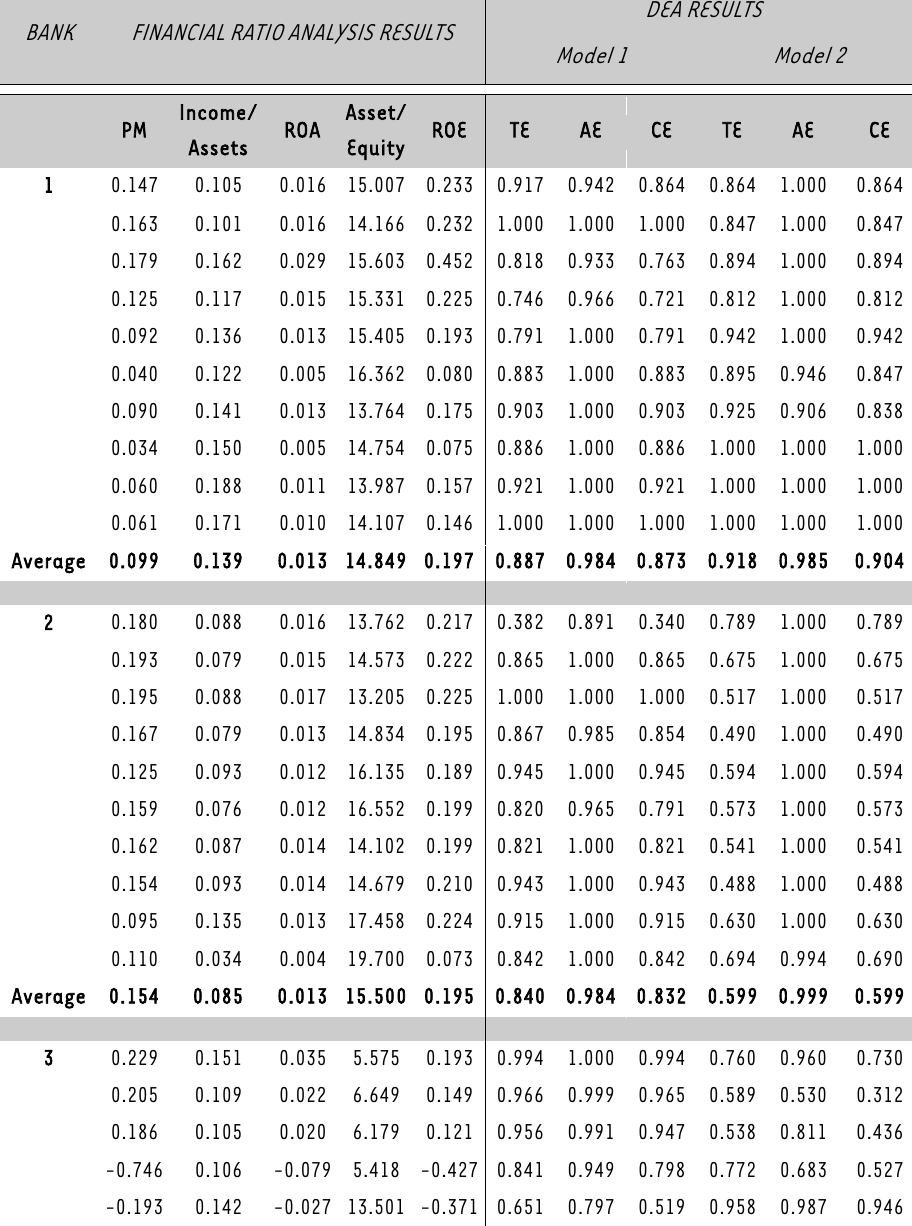
TABLE 1: Annual results from 1998 to 2007 per bank (n = 10) and in total (n = 50) of financial ratios analysis, DEA Model 1 and Model